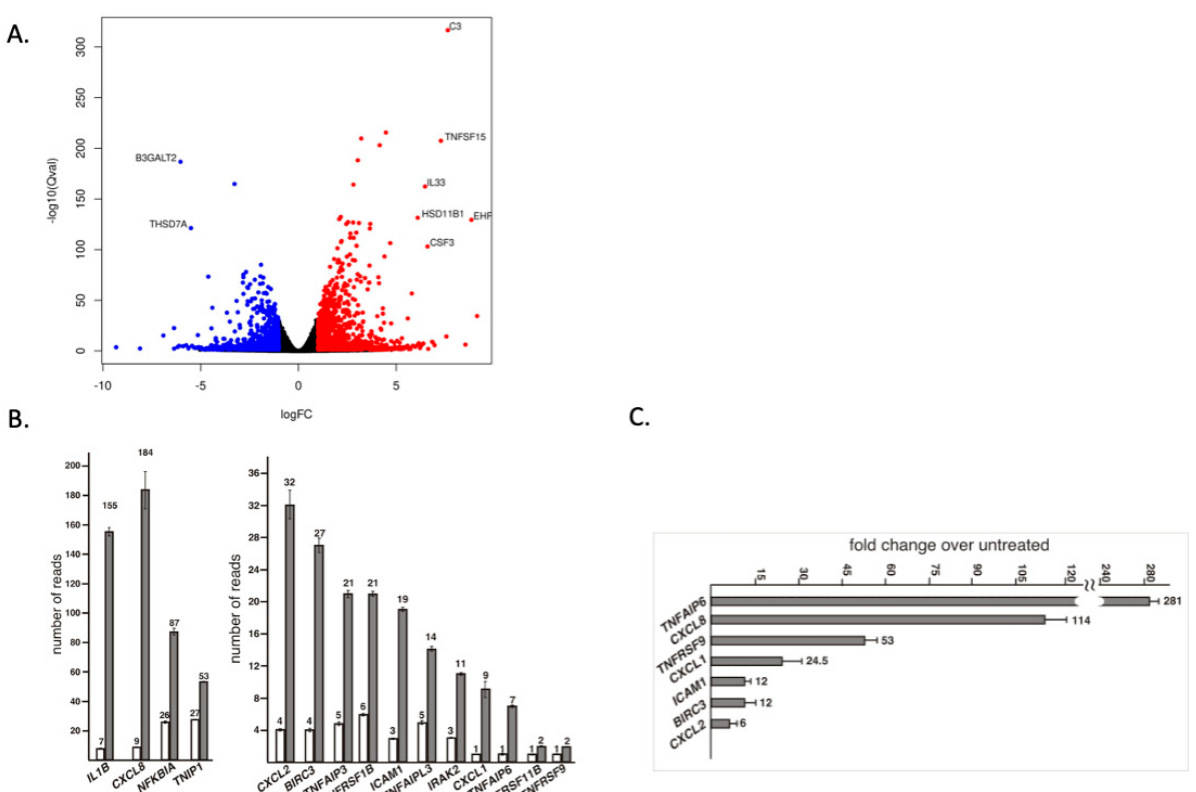
Figure 6. ( A ) A volcano plot of RNAseq analysis of HAA1 cells upon HDACi treatment. The genes with Qval < 4.78 × 10 − 95 and log2 (fold change) > 5 are labeled. ( B ) RNA-seq analysis of gene expression in HAA1 cells after HDACi treatment showing increased expression of a number of TNF-alpha pathway related genes. All values are highly significant, p < 0.001. ( C ) qRT-PCR analysis of gene expression in HAA1 cells after HDAC-inhibitor treatment, confirming increased expression of TNF-alpha pathway genes. All values are significant, p < 0.05.